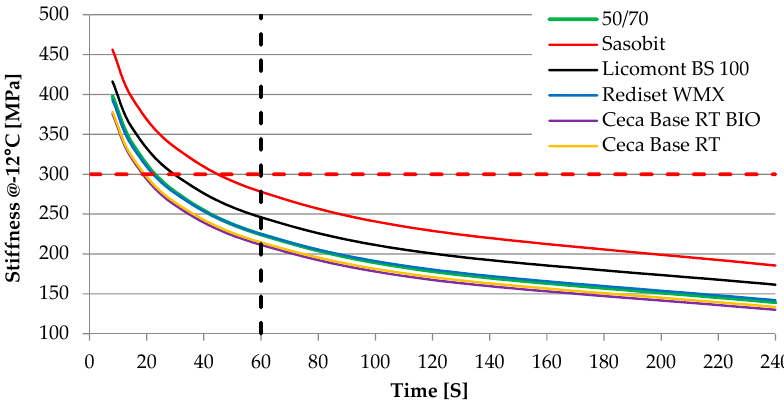
Figure 1. Stiffness obtained at –12 °C from the BBR test.